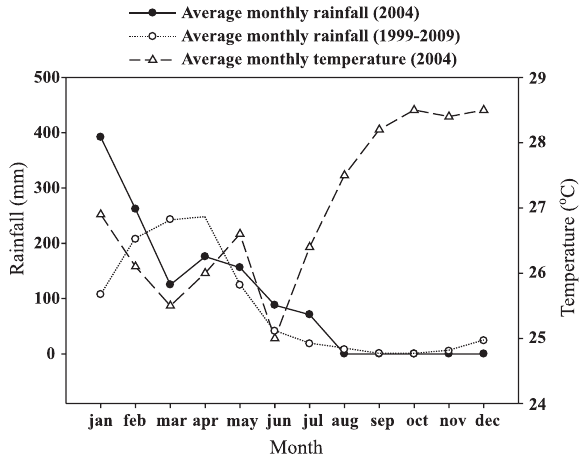
Figure 1. Average monthly rainfall and temperature in Sobral,